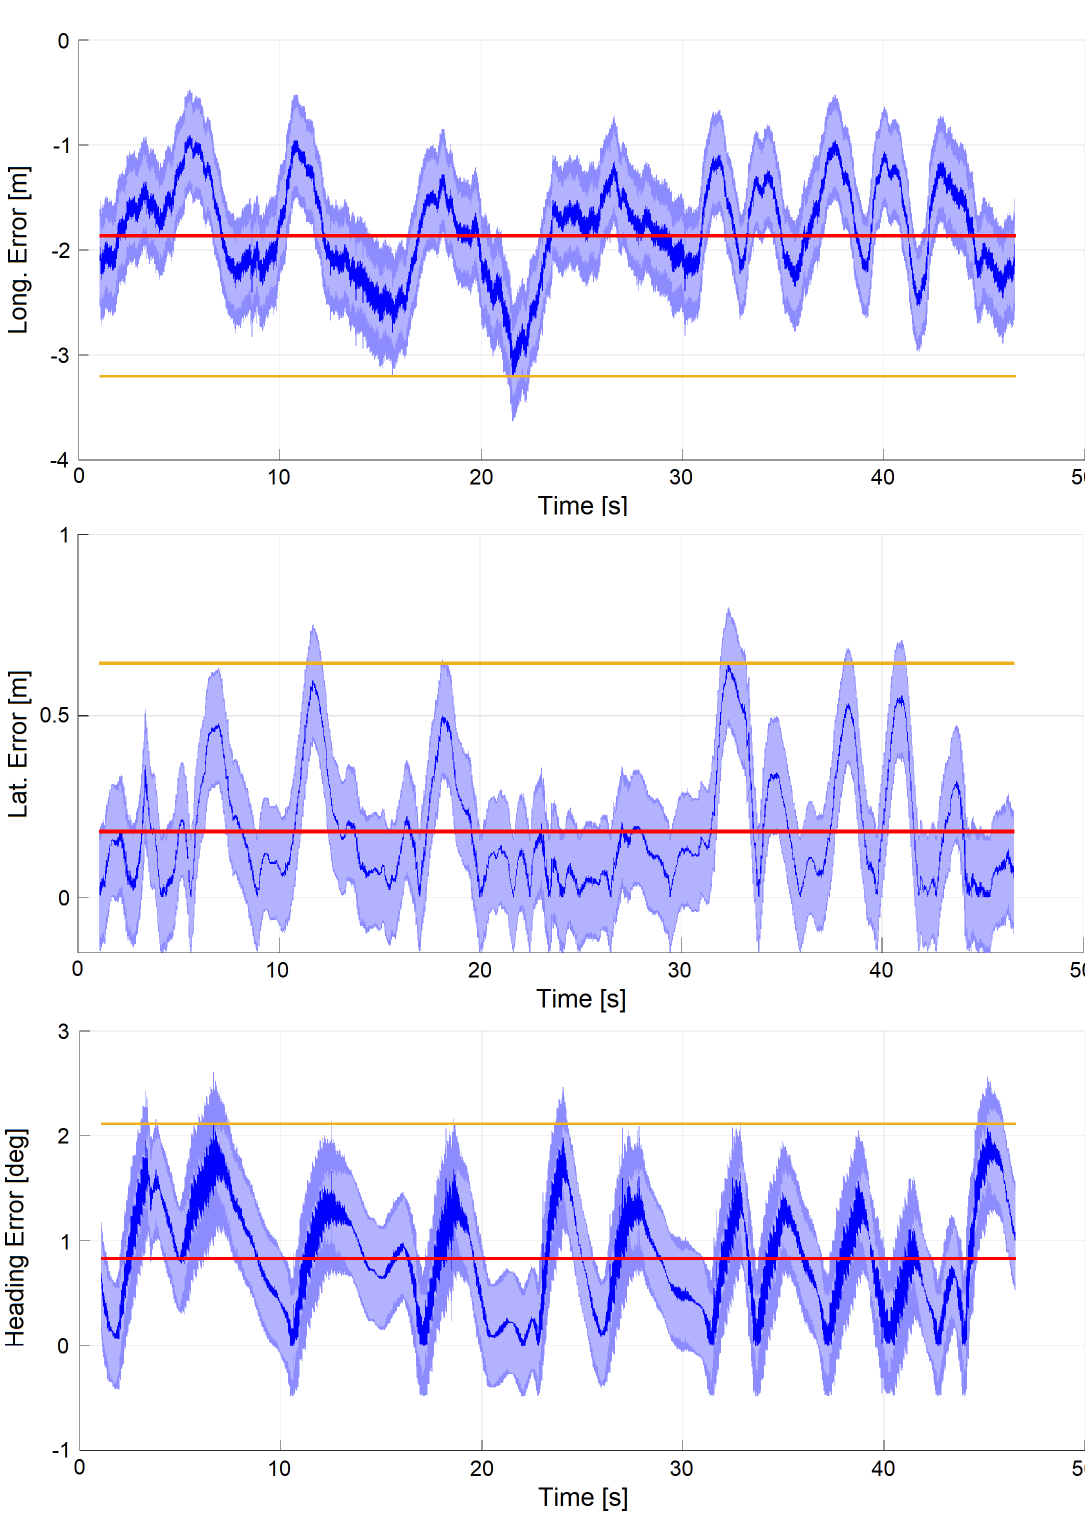
Figure 15. Manually driven lap at v max = 100 km/h. Signals are plotted together with standard deviation (light blue), mean (red) and maximum error